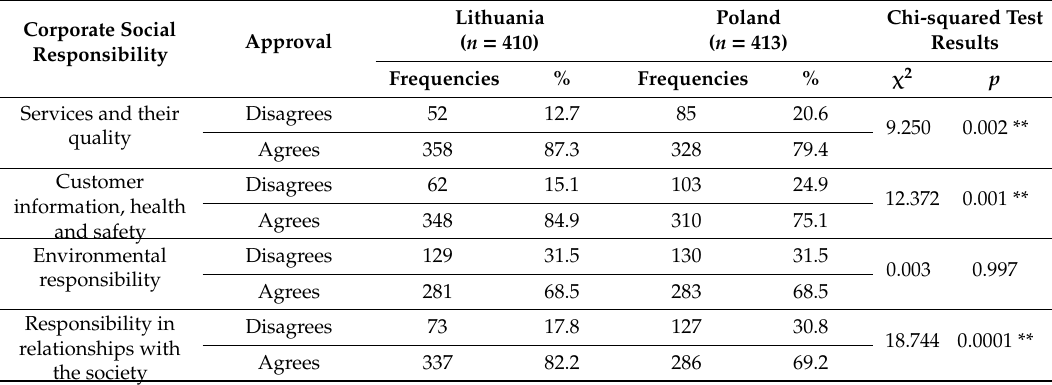
Table 6. Corporate social responsibility in Lithuanian and Polish organizations: the subscale